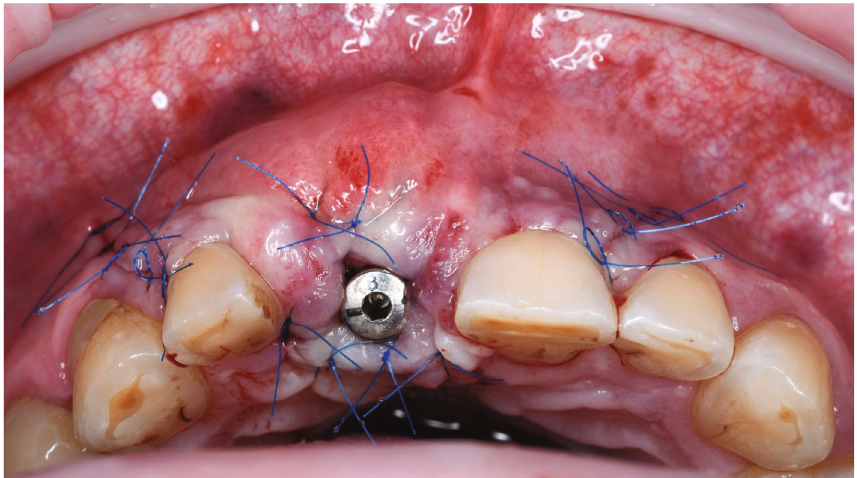
Figure 11: Passive wound